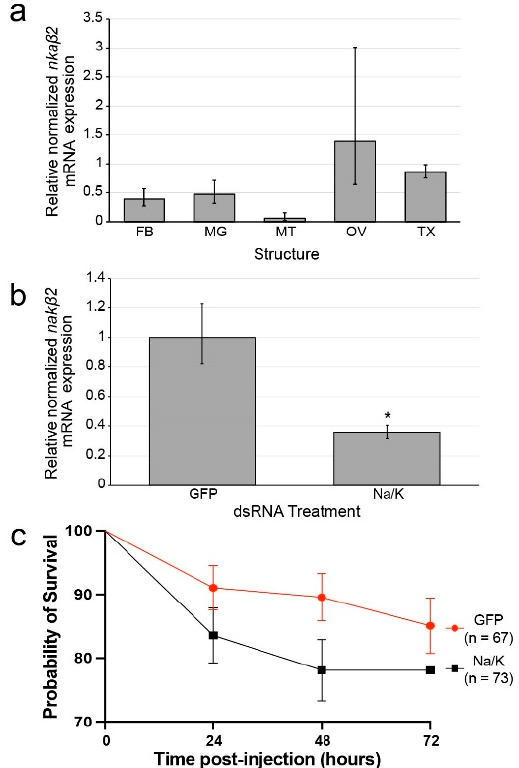
Figure 1. Profiling of nka β 2 expression and RNAi knockdown effect. ( a ). qRT-PCR reveals elevated expression of nka β 2 mRNA in ovaries relative to other tissues. While mean nka β 2 expression was highest in ovaries, expression was not significantly different between any tissue types. FB: fat body; MG: midgut; MT: Malpighian tubules; OV: ovary; TX: thorax. Statistical analysis was performed using a one-way ANOVA. ( b ). RNAi knockdown of nka β 2 (Na/K) results in significantly reduced nka β 2 mRNA expression in nka β 2 dsRNA-injected mosquitoes relative to GFP dsRNA-injected control mosquitoes 3 days PI. Significant differences between injected groups were determined using an unpaired t-test. Significant differences are marked with an asterisk. ( c ). RNAi knockdown of nka β 2 expression caused reduction in survival of female Ae. aegypti relative to GFP dsRNA-injected female Ae. aegypti through 72 h PI. Significance between survival curves was determined using a Mantel–Cox log-rank test.